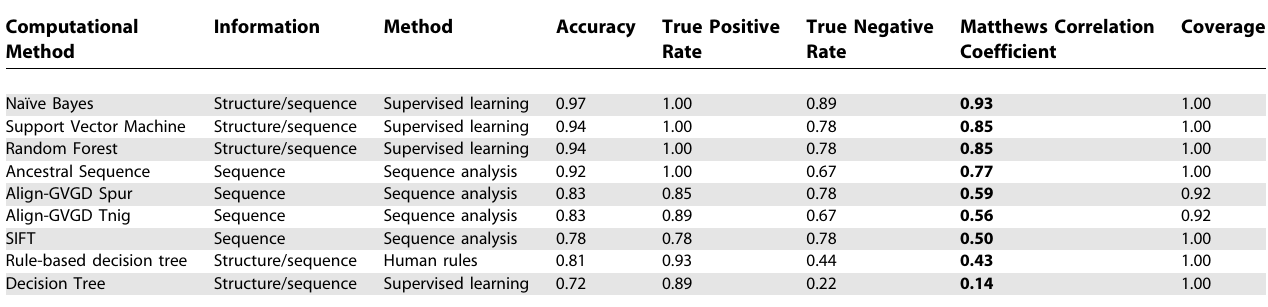
Table 1. Classification Performance of Nine Computational Methods for UCV Classification, According to Agreement with the BRCA1 Transactivation Assay of 36 Missense Variants Computational